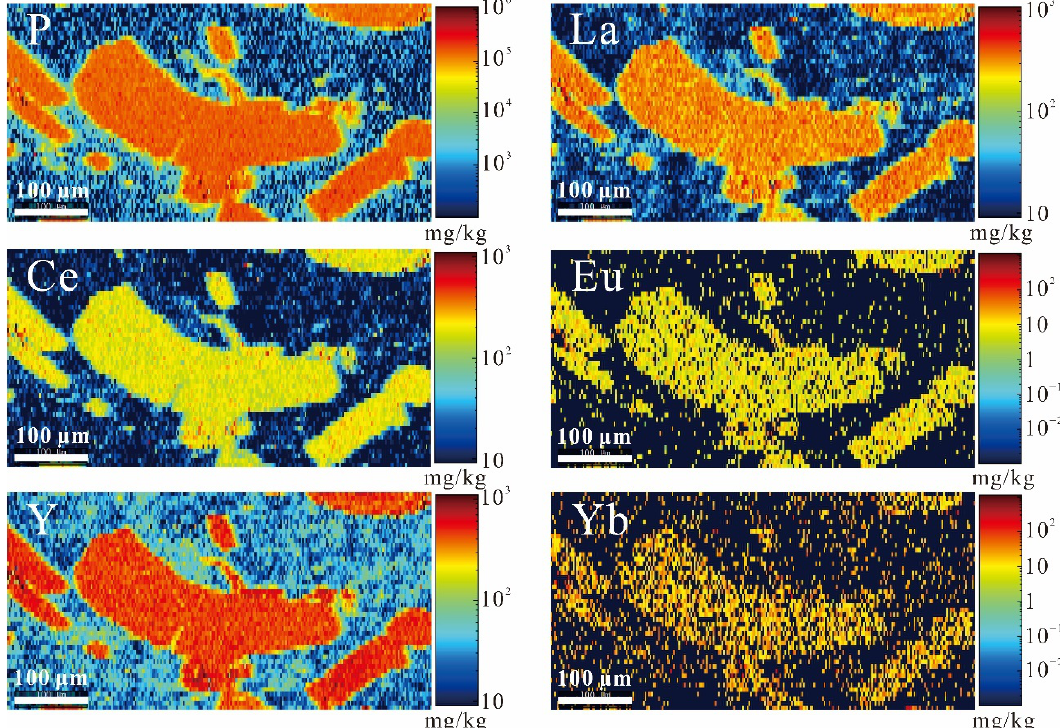
Figure 6. REY mapping of francolite grain from the LFC section.